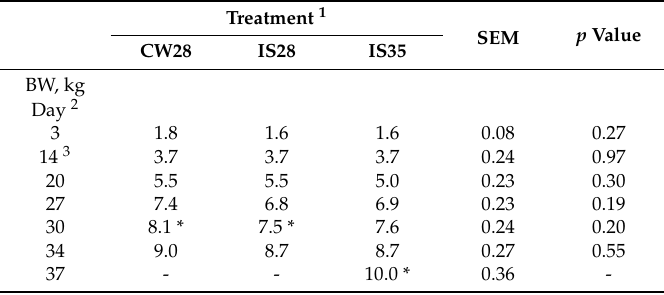
Table 1. Effect of intermittent suckling with and without older weaning age on the body weight of piglets between 3 and 90 days of